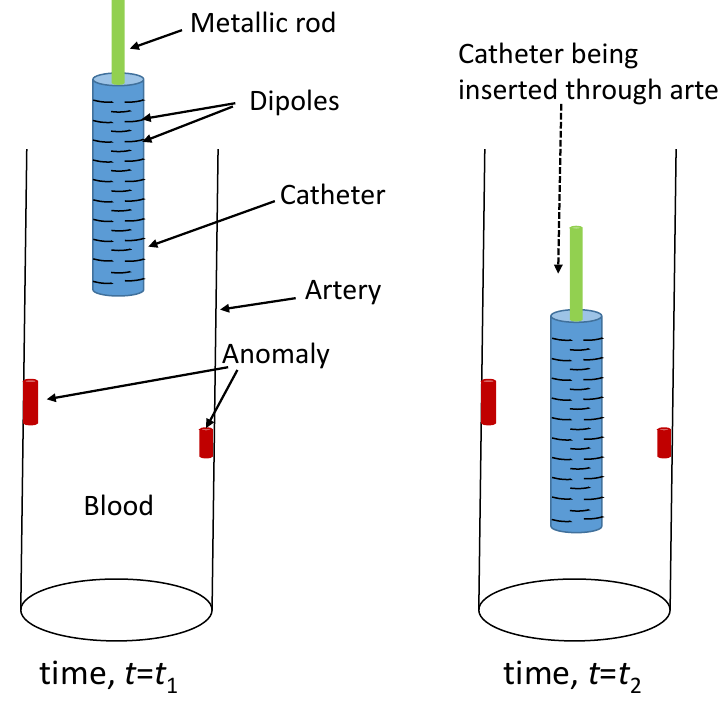
Figure 5. Two sets of measurements, S 1 and S 2, are being taken at times, t = t 1 and t = t 2 , respec- tively.